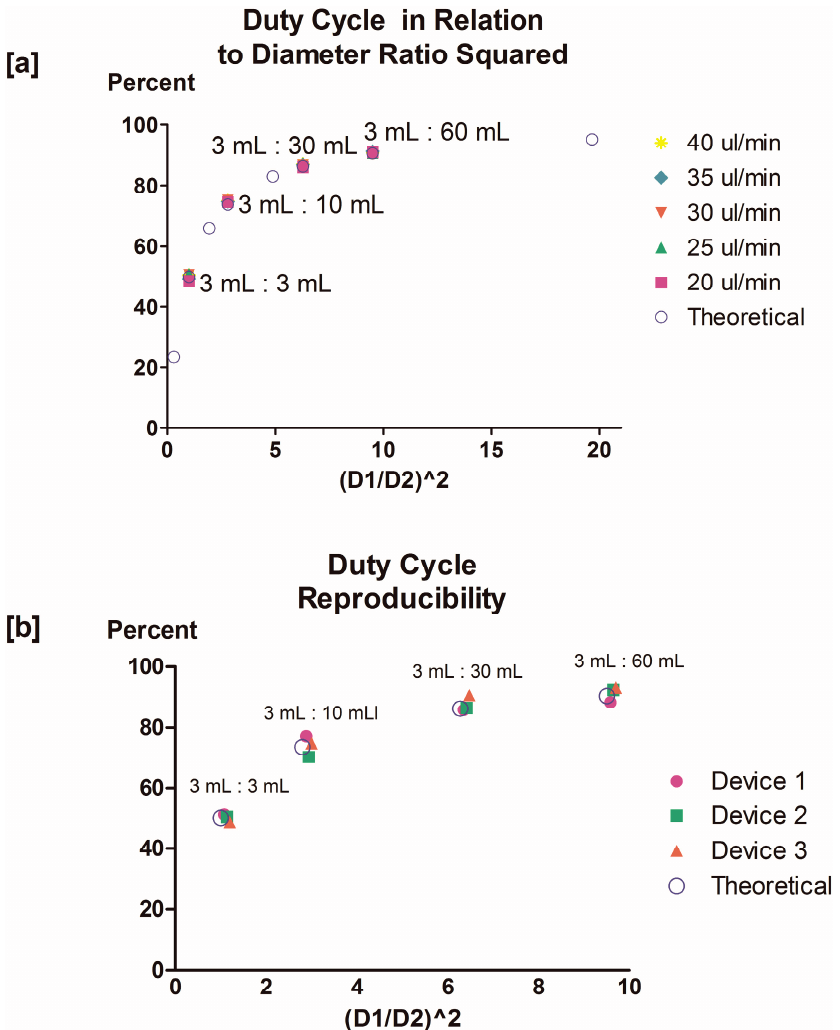
Highlighted values represent syringe combinations studied experimentally. The duty cycle values presented are calculated with respect to Syringe 2 . Utilizing this system, we succeeded in achieving duty cycles ranging from 50% to 90% (Figure 3a), reproducible across multiple devices ( n = 3) (Figure 3b). Figure 3. Experimental duty cycles overlap predicted values; flow rate ratio manipulation stably and reproducibly regulates duty cycle across multiple devices. ( a ) Filled symbols represent duty cycle values observed and averaged across four syringe combinations and at five different total volumetric inflow rates. Unfilled blue circles represent predicted duty cycle values. All values are derived from time series data containing >6 oscillations. Duty cycle values are plotted against the squared ratio between syringe diameter ( Syringe 2: Syringe 1) to illustrate the general trend observed. ( b ) Duty cycle data collected from multiple devices ( n = 3) is presented against the squared ratio between syringe diameter ( Syringe 2: Syringe 1). Filled symbols represent duty cycle values recorded and averaged across four syringe combinations for total volumetric inflow rates ranging from 5 to 40 μ L/min. Unfilled circles represent theoretical (predicted) duty cycle values. All averaged values are derived from time series data containing >6 oscillations. Error bars represent the calculated standard deviation for all duty cycle values recorded from each of three devices for all tested inflow rate